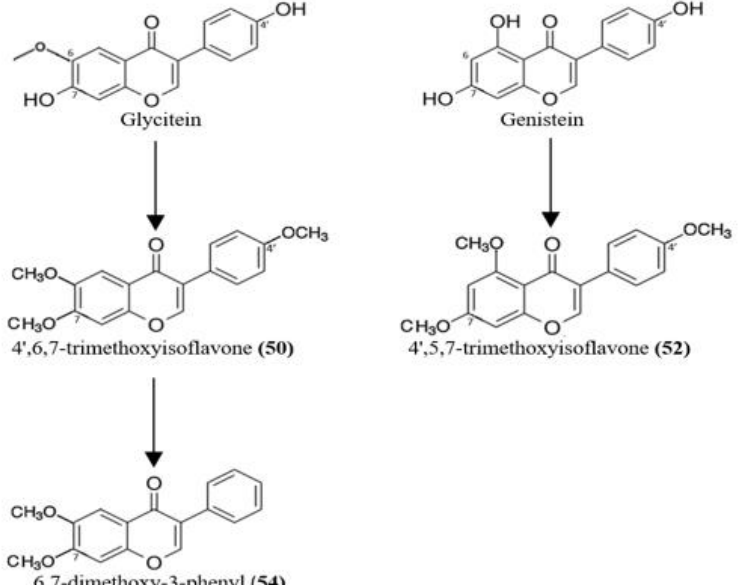
Figure 4. Proposed biotransformation of glycitiein to 50 and 54 , and genistein to 52 , respectively.